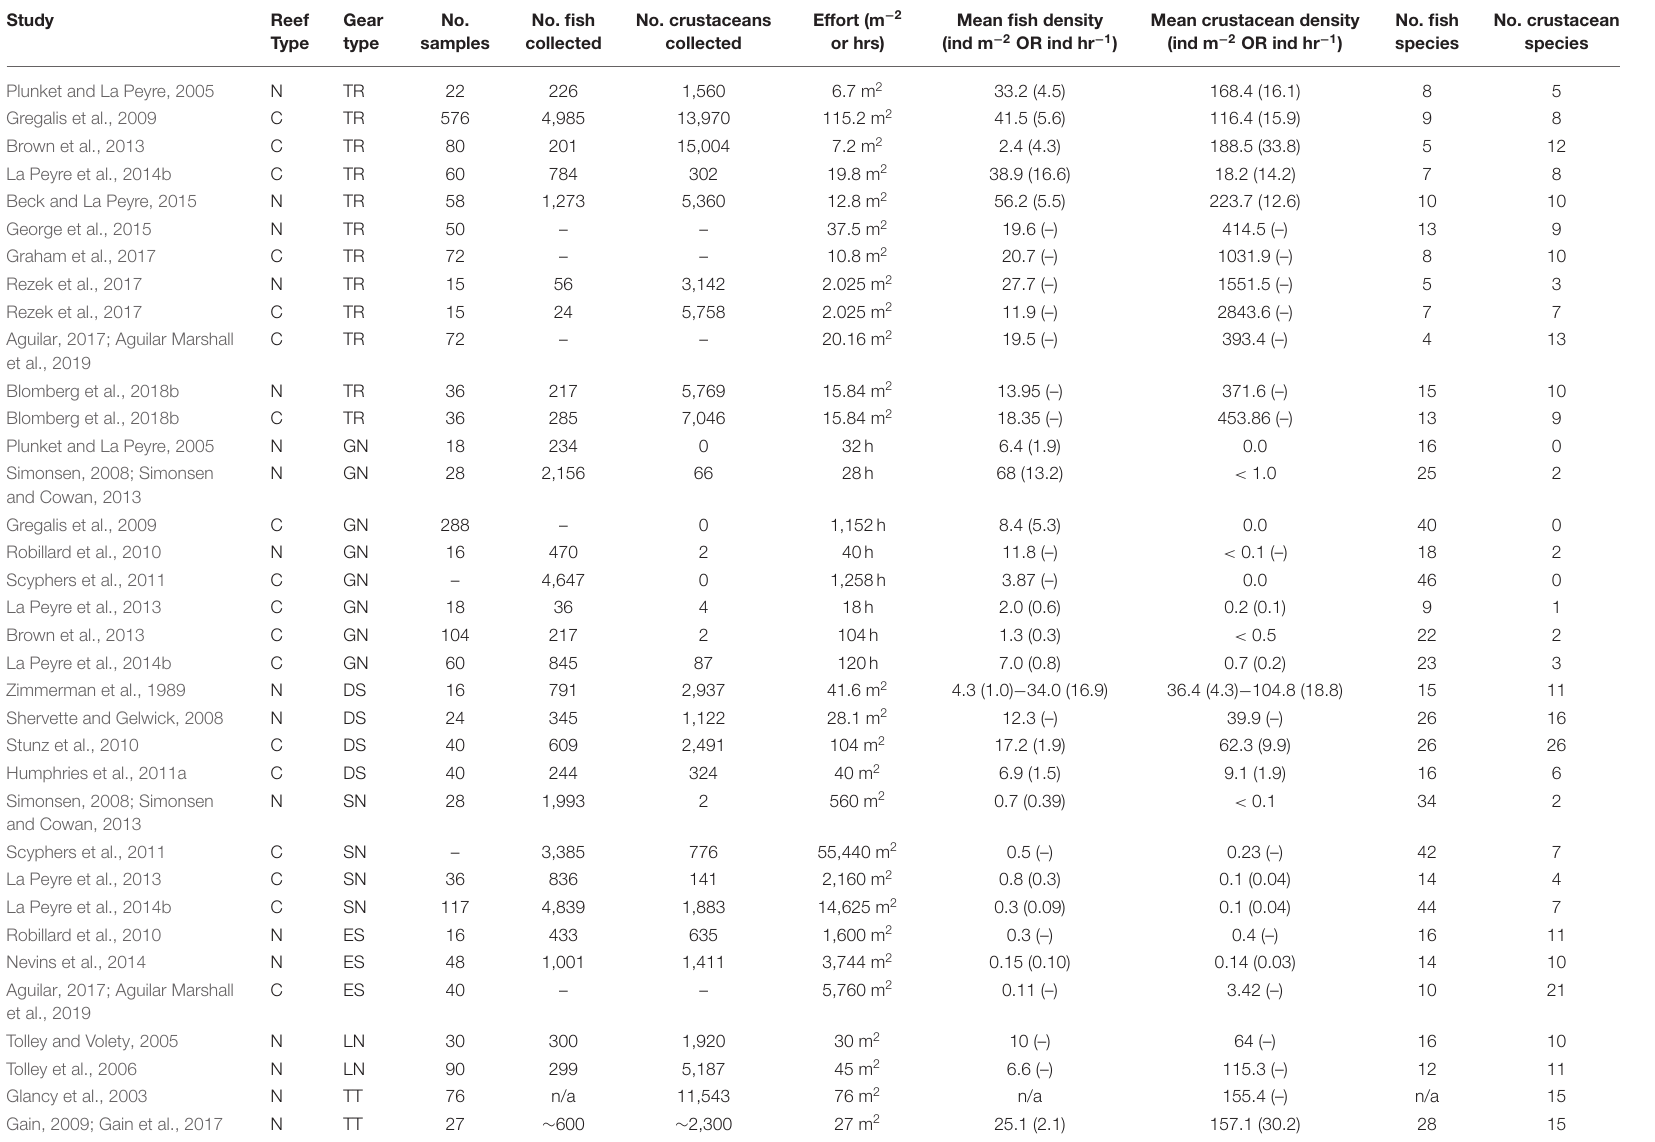
TABLE 2 | Synthesis of sampling effort and catch for studies for the northern Gulf of